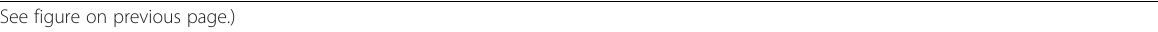
Table 1 DGC interactors are putative Dg-Dys-Syn1 regulated miRNA targets